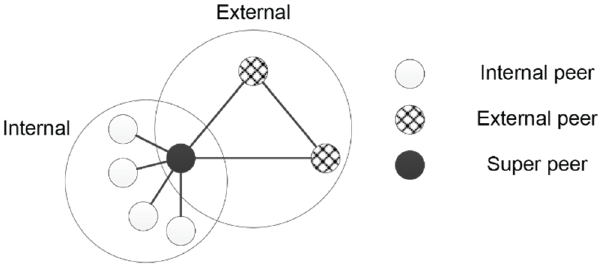
Figure 1. Internal and external groups of a free scale P2P (peer-to-peer) network.